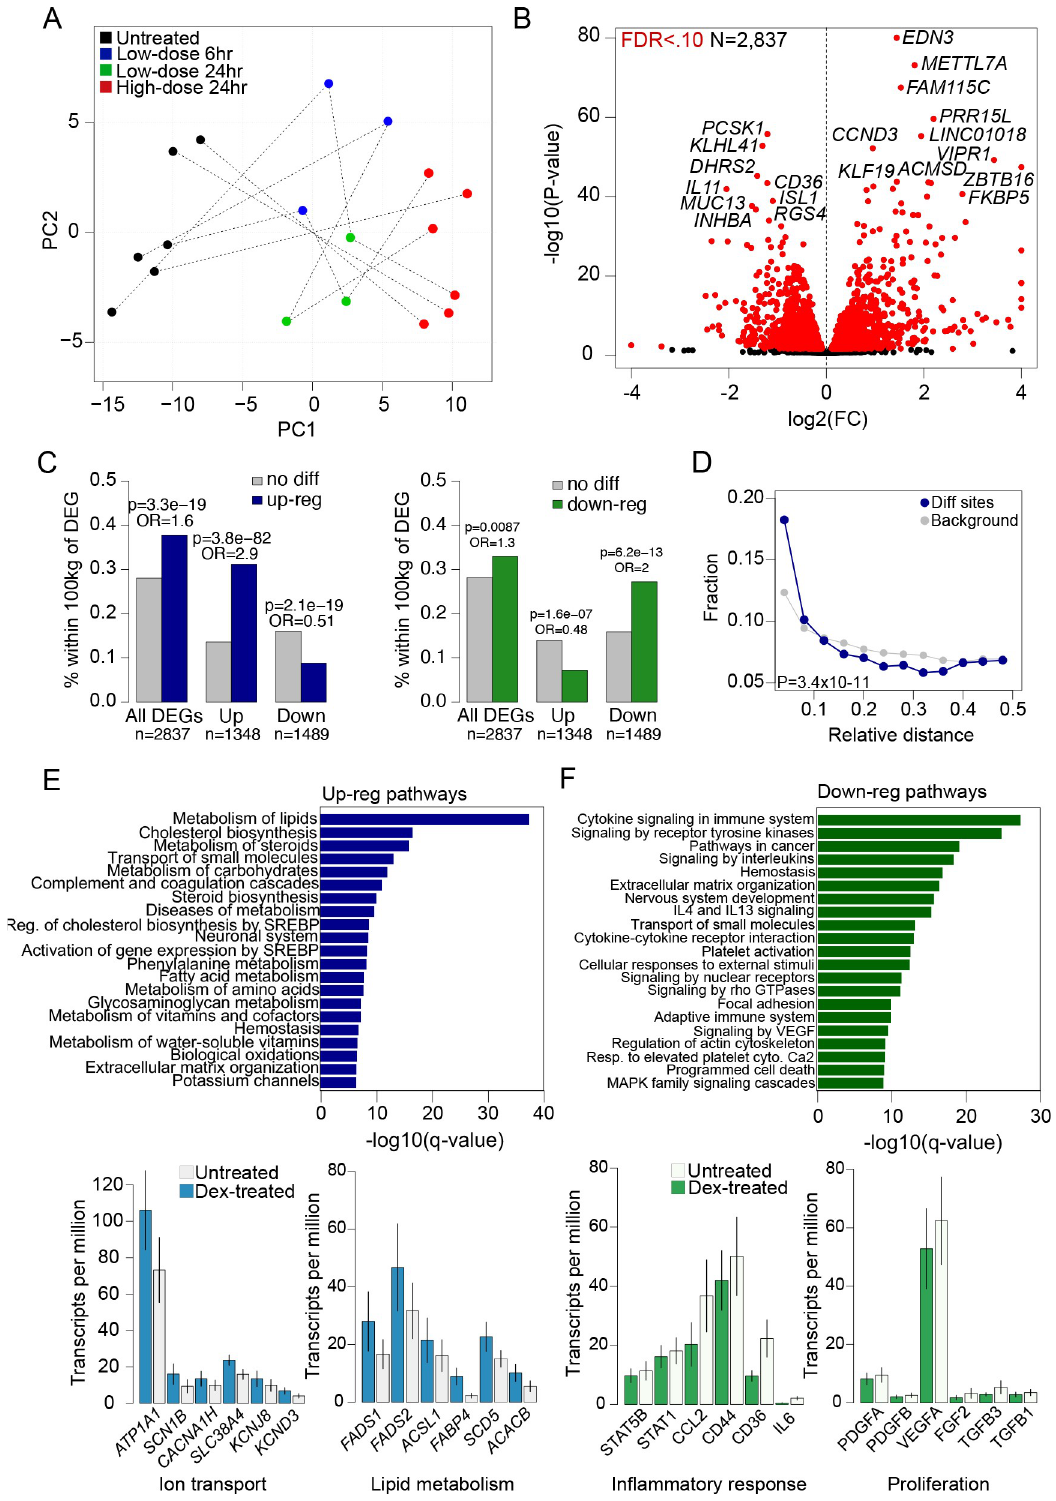
Fig 3. Glucocorticoid signaling affects gene expression levels in pancreatic islets. (A) Principal components plot of gene expression from high-dose (red) and low-dose (green 24hr, blue 6hr) glucocorticoid-treated and untreated (black) islets from a total of 6 samples. Dashed lines connect assays from the same sample. (B) Volcano plot showing genes with differential expression